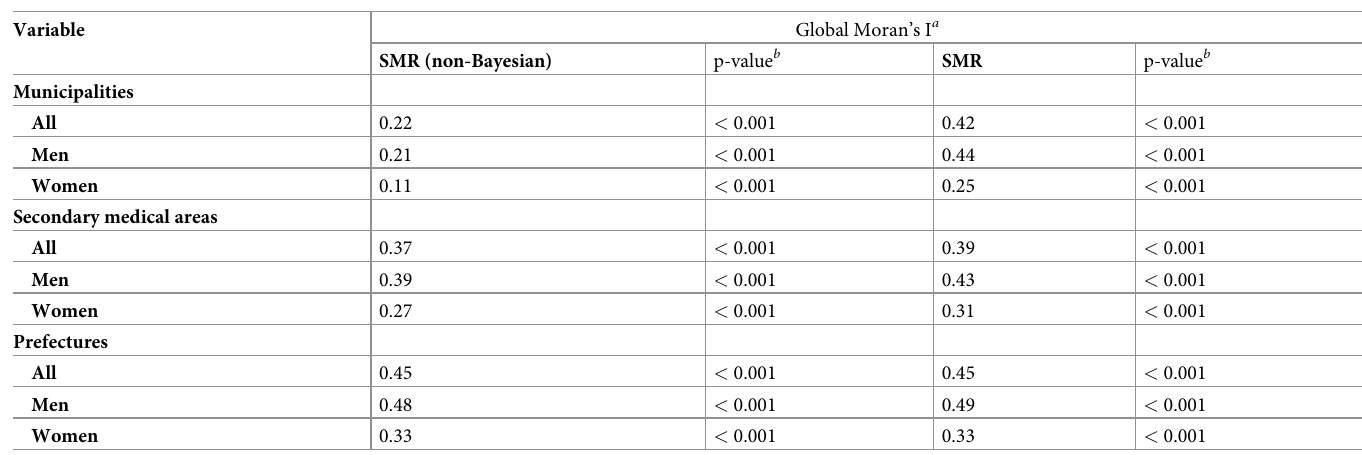
Table 2. Global Moran’s